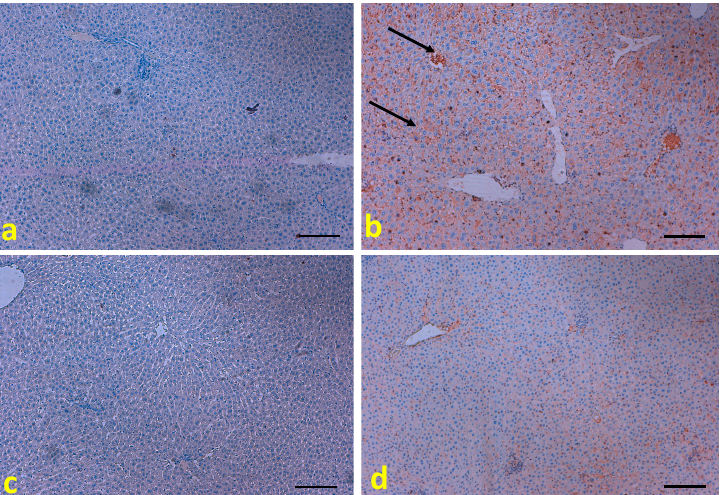
Figure 12. The Cox-2 protein expression was analyzed in different experimental groups. ( a ) The control animals did not show any expression; ( b ) The significantly high expression of Cox-2 protein was noticed in STZ-induced diabetic rats; ( c ) Cox-2 protein expression was diminished in STZ- induced plus TQ administered rats; ( d ) PC group did not show any expression (Scale bar = 100 µ m).